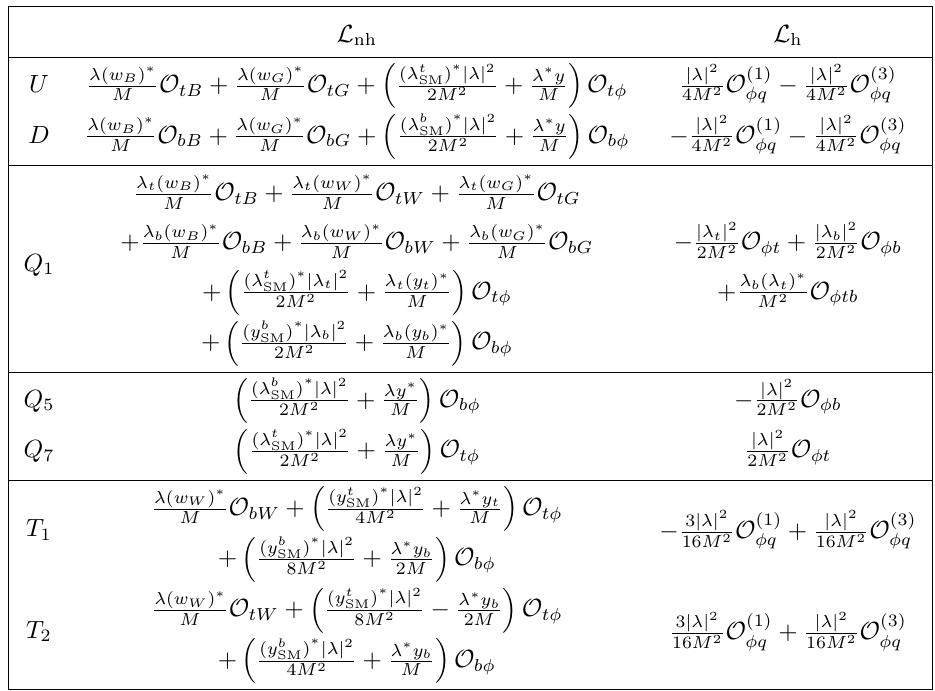
Table 4 . Dimension-6 e(cid:11)ective Lagrangian generated by tree-level matching of the e(cid:11)ective theory with each multiplet to the SMEFT. The contributions to Hermitian and non-Hermitian operators are separated in L h and L nh . The complete e(cid:11)ective Lagrangian is L h +( L nh +h.c.). The de(cid:12)nitions of the operators O i are given in table 5.